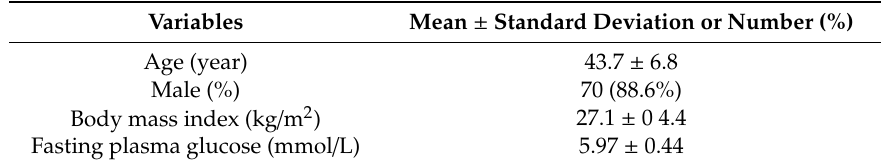
Table 1. Clinical characteristics of the study population ( n =